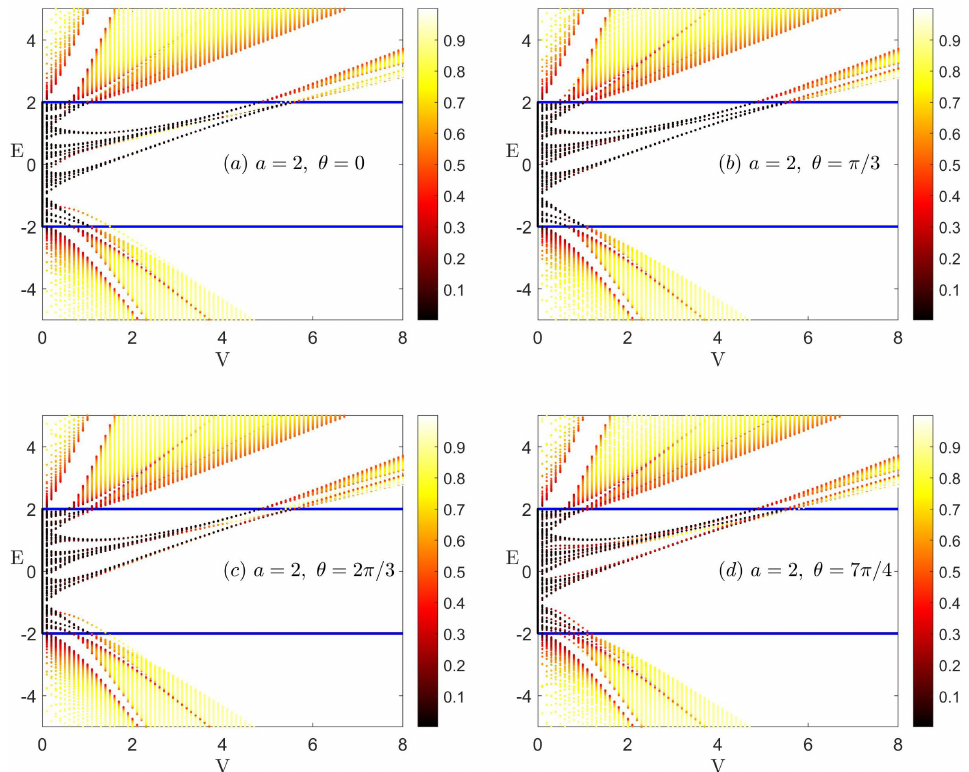
Figure 4: Inverse participation ratio IPR versus potential amplitude and energy for the model of Eqs. (1) and (2), and various values of the phase θ